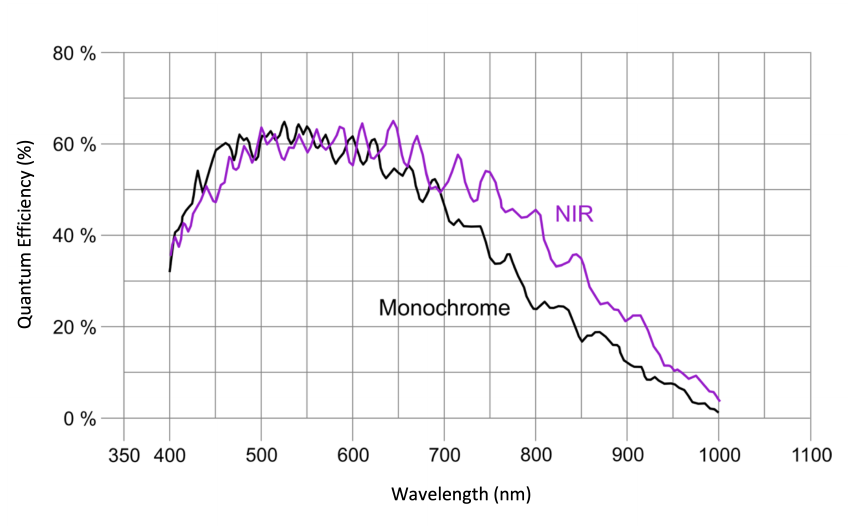
Figure 2. Comparison between the monochrome and the NIR version of the CMV2000-3E12M